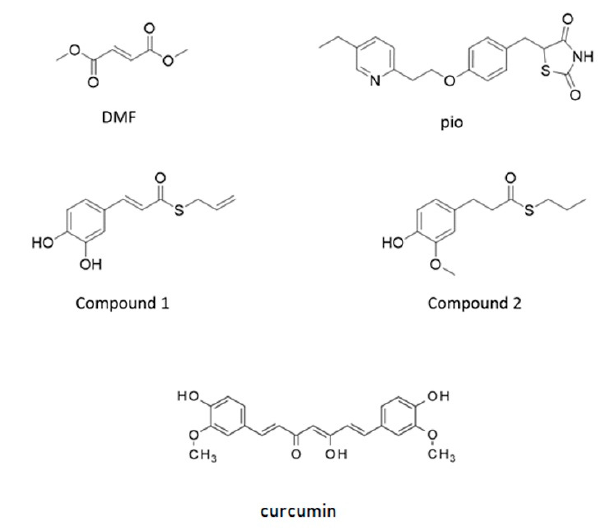
Figure 1. Structure of molecules used as agents activating nuclear factor-erythroid 2-related factor (NRF2) and peroxisome proliferator-activated receptor gamma (PPAR- γ ). Structure of dimethyl-fumarate (DMF), pioglitazone (pio), curcumin (Curc), and compounds synthesized by combining the hydroxycinnamoyl motif derived from curcumin and the allyl mercaptan moiety of garlic organosulfur compounds (Compound 1 and Compound 2). Compound 1 bears a catechol moiety and an α , β -unsaturated carbonyl group, both conferring electrophilic features; compound 2 lacks these moieties.